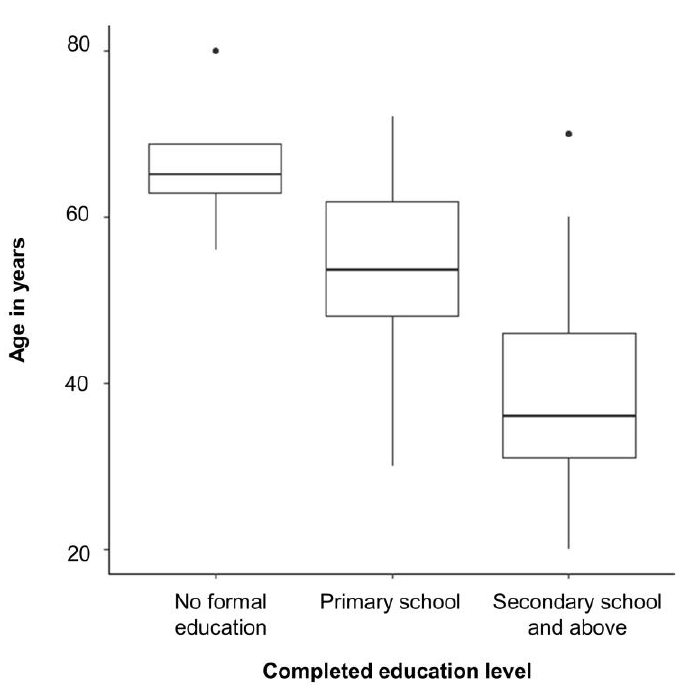
Fig. A 3 .1: The relationship between the respondents’ age and education level. The thick horizontal bars in the box represent the median, bottom and top of the box are the 25th and 75th percentiles respectively. Whiskers extend until the lowest and highest